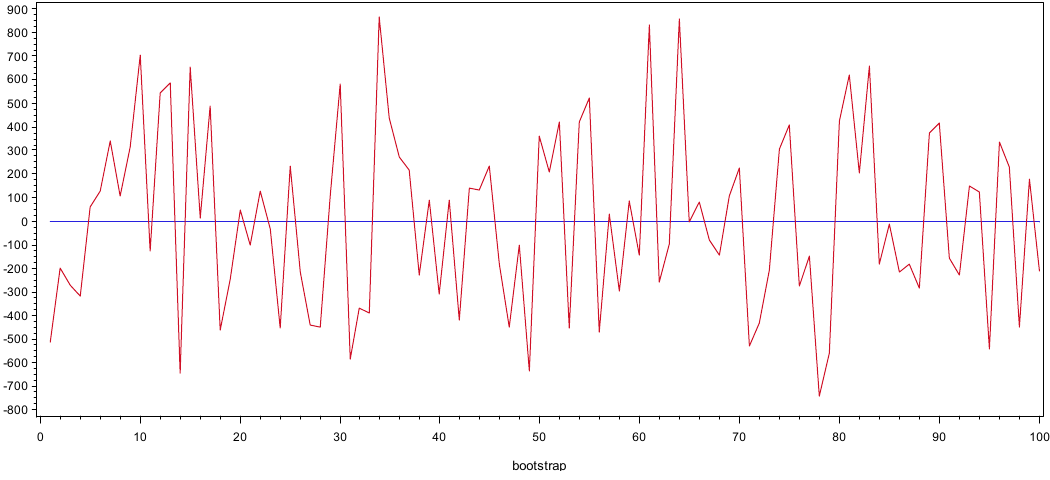
(cid:3554) (in blue). (cid:3021) (cid:3550) (in red) and 𝛽 (cid:3021)